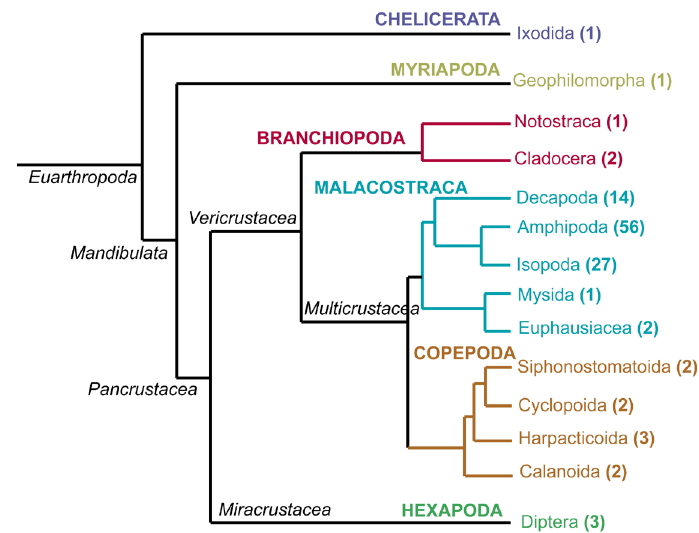
Figure 1. Phylogenetic relationship of Crustacea. The number of species within each taxon is denoted in